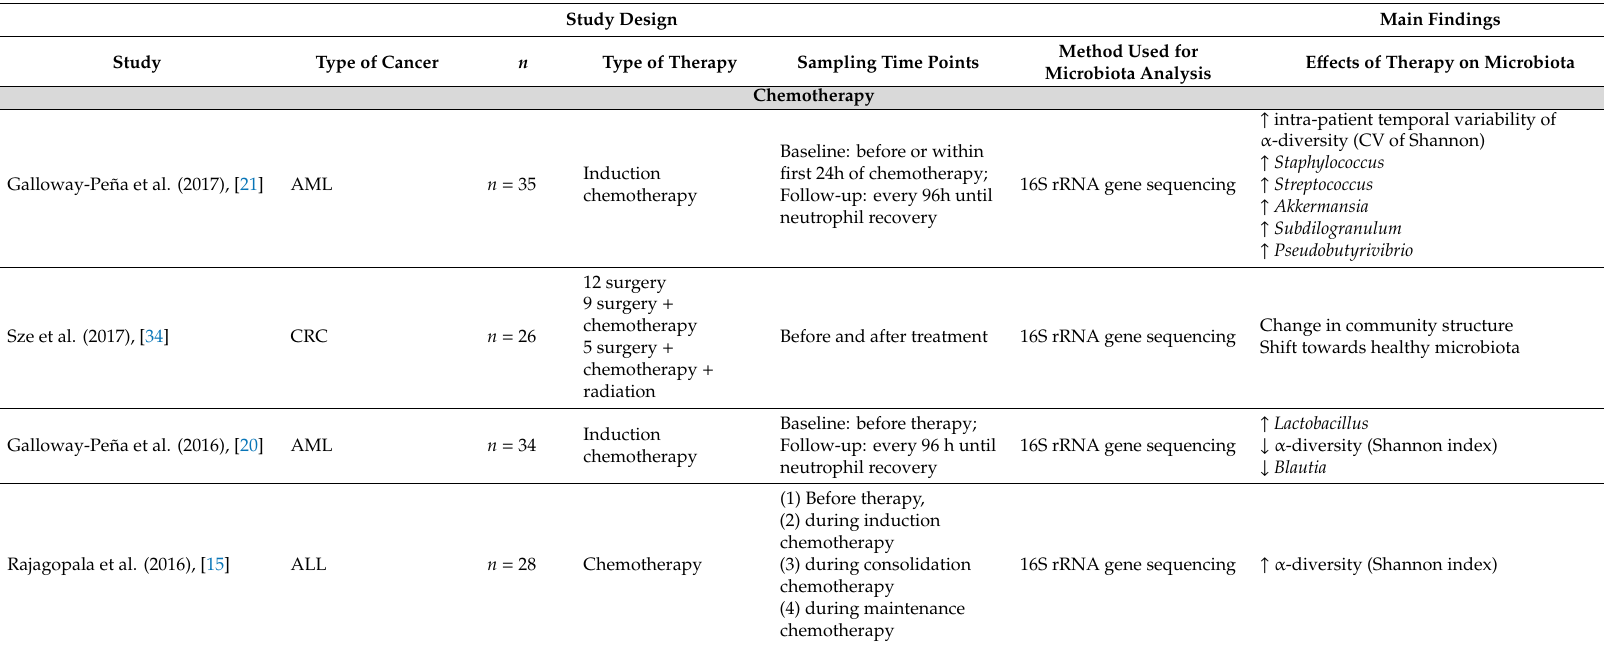
Table 2. Clinical studies assessing intestinal microbiota changes during systemic cancer therapy by longitudinal